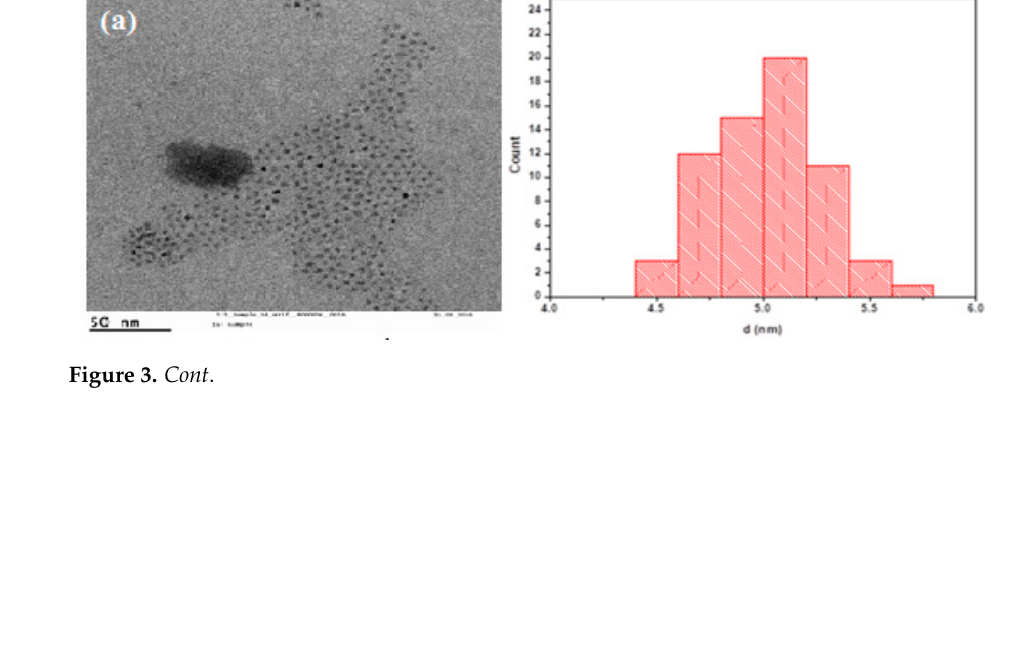
Figure 2. Schematic representation of Cu-doped ZnS and CdS shell.